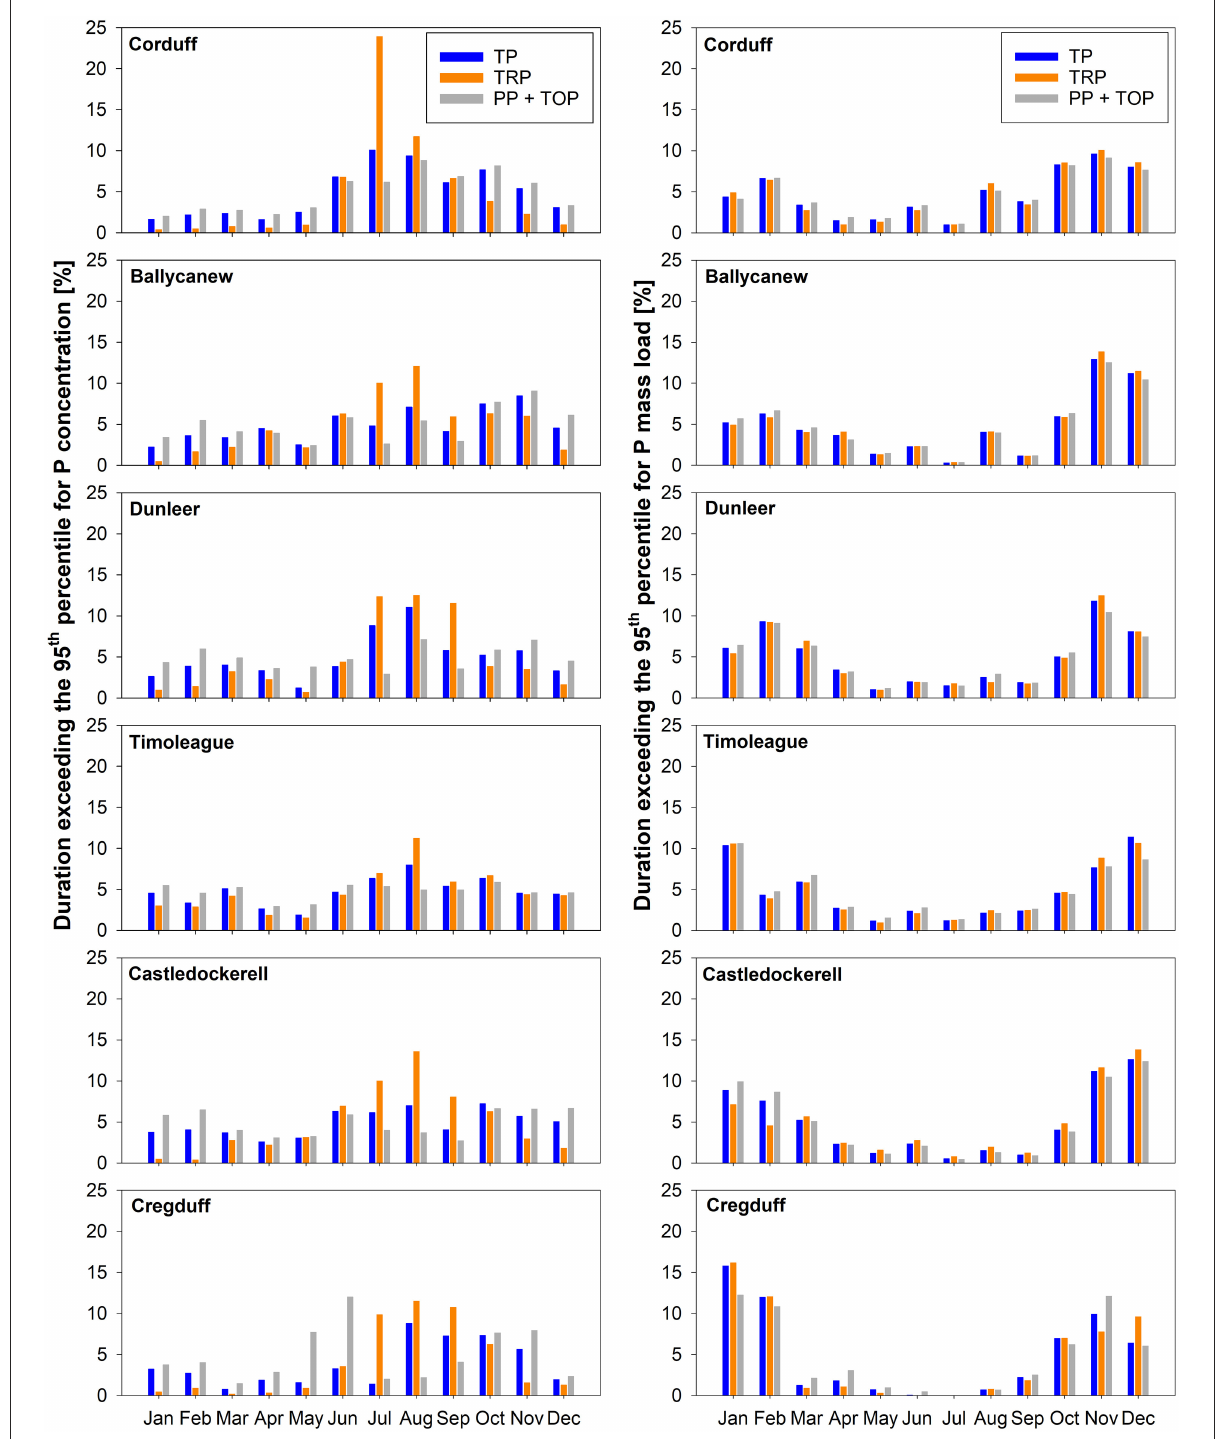
FIGURE4 Duration of time per month (percent) exceeding the 95th PCTL of P concentrations (left) and P mass loads (right) for the six study catchments. The data is based on hourly averages of concentrations and hourly totals of mass loads for 10 years (1st October 2010 to 30th September